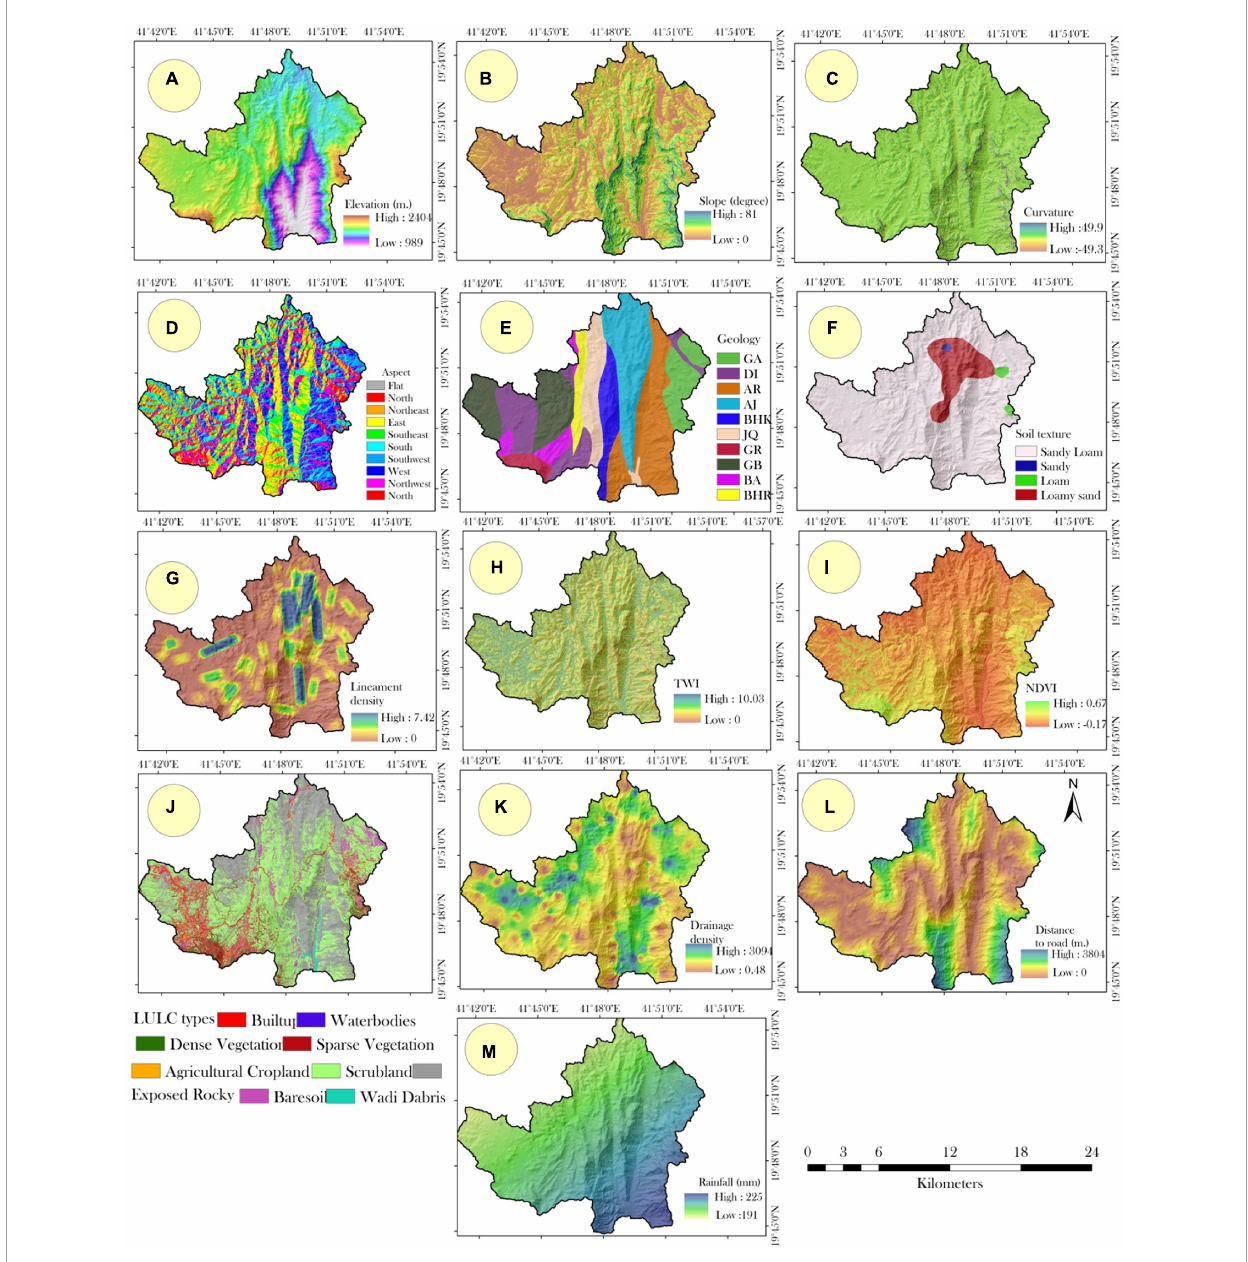
FIGURE2 The landslide triggering factors, such as (A) elevation, (B) slope, (C) curvature, (D) aspect, (E) geology, (F) soil texture, (G) lineament density, (H) topographic wetness index (TWI), (I) normalized differentiation vegetation index (NDVI), (J) land use land cover (LULC) types, (K) drainage density, (L) distance to road, (M)